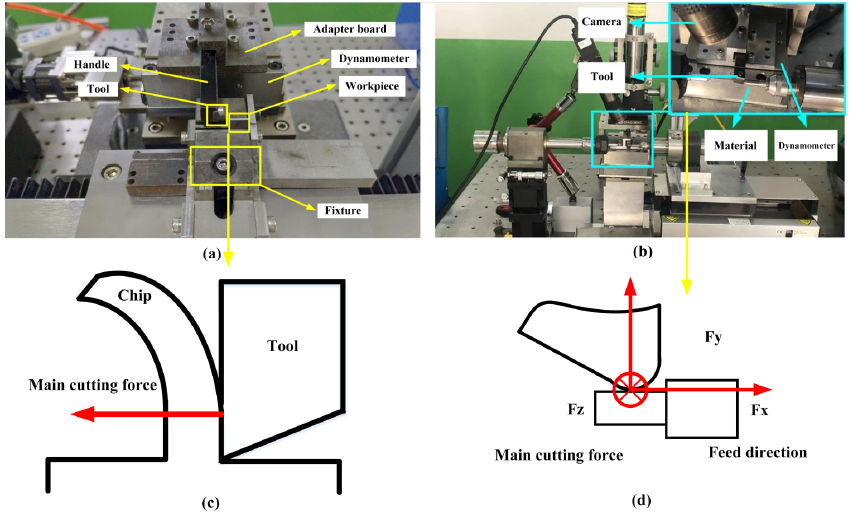
Figure 2. Experimental setups for orthogonal cutting ( a ) and micro-turning ( b ). Cutting forces are shown in ( c ) and ( d ).